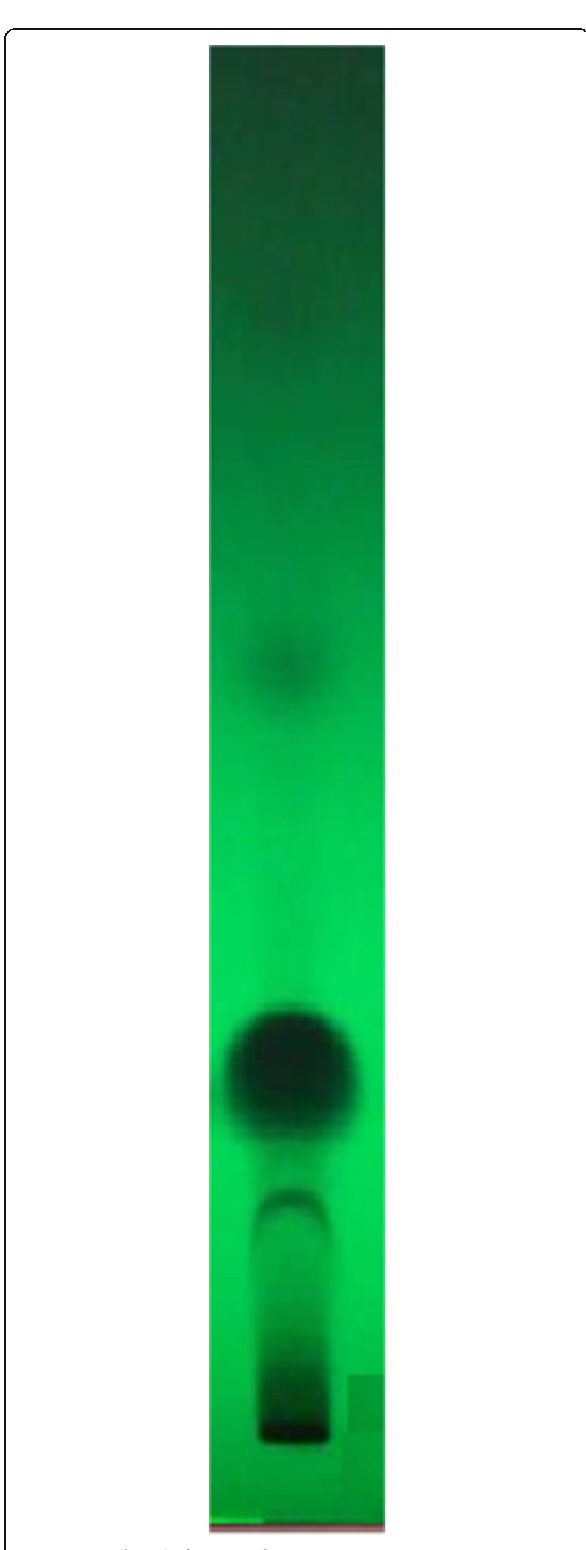
Fig. 1 TLC of crude fraction of